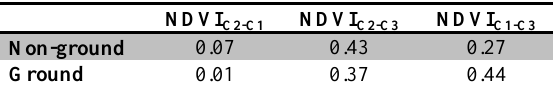
Table 3. Intersection points of Gaussian